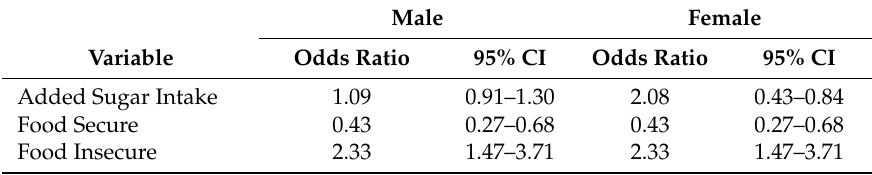
Table 4. Logistic regression model predicting anxiety status in male and female